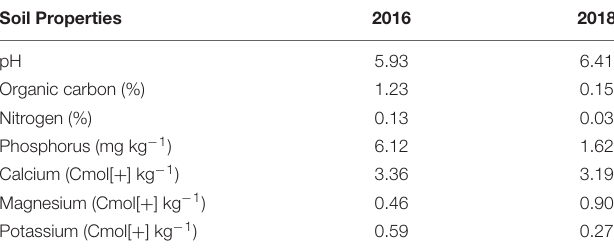
TABLE 1 | Soil chemical properties of the trial sites at IITA Ibadan, Nigeria. Soil